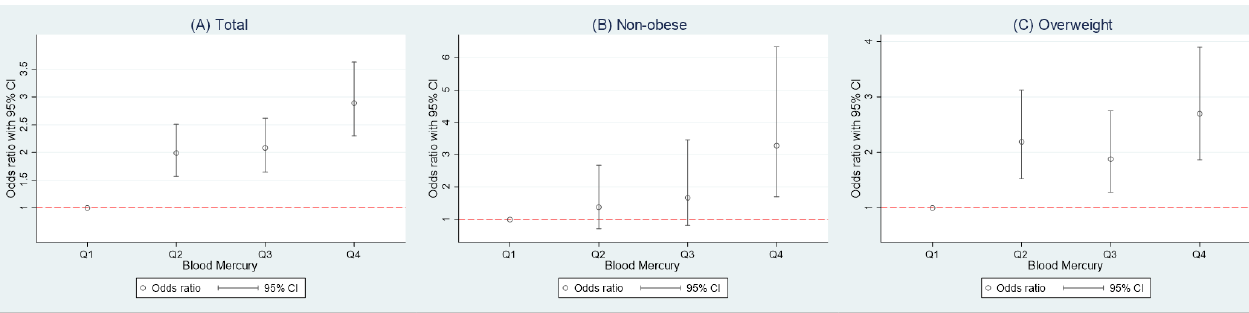
Figure 2. Multivariate odds ratio and 95% confidence intervals (CI) for NAFLD ( A ) Total, ( B ) Non-obese, and ( C ) Overweight according to the quartile of blood mercury levels. Adjusted for age, sex, smoking, drinking, exercise, marital status, education, income, hypertension, diabetes mellitus, hyperlipidemia, and seafood consumption within one week. Non-